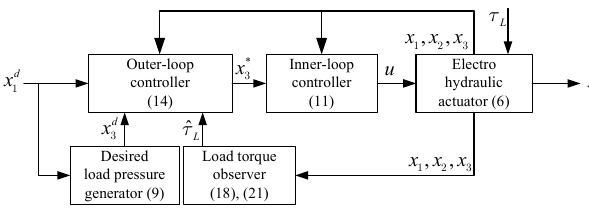
Figure 3. Block diagram of the overall control system for the EHA.